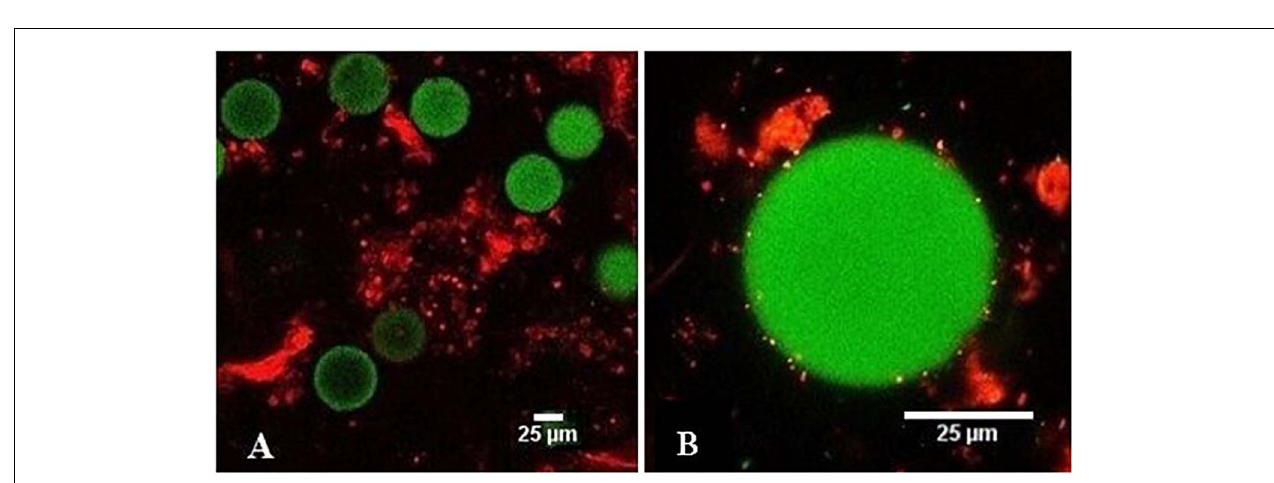
FIGURE 5 | Viscosity curves for the mucus – PS microspheres suspensions. (A) The concentration of PS microspheres was kept constant at 8000 particles/mL, the mucus concentration was increased from 1 to 6% (w/v). Two control mucus samples without PS microspheres are shown (c3, c6 with 3 and 6% mucus, respectively). (B) The concentration of mucus was kept constant at 3% whereas the concentration of PS microspheres was increased from 2000 to 9600 particles/mL. Two control samples without added mucus are shown (c8000, c9600 with 8000 and 9600 particles/mL, respectively). The error bars represent standard deviations ( n = 5–6 for PS samples and 2–3 for control samples).